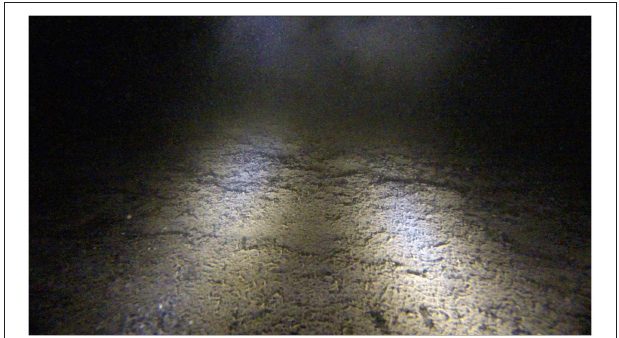
FIGURE 9 | Image from videos taken in 2013 during jump dives to 272m at Kraken site (14:20). A low mat-like structure is evident that appears to consist of several layers of tubular structures ( ∼ 10cm long) with one upright extremity with pinkish moving features. These are possibly polychaete tubeworms, Siboglinidae. Sponges and molluscs are present on top of the tubeworm mat and small planktonic forms, ostracods, shrimps are apparent above the lakebed. The flow of particles seems to move slowly upwards with simmering